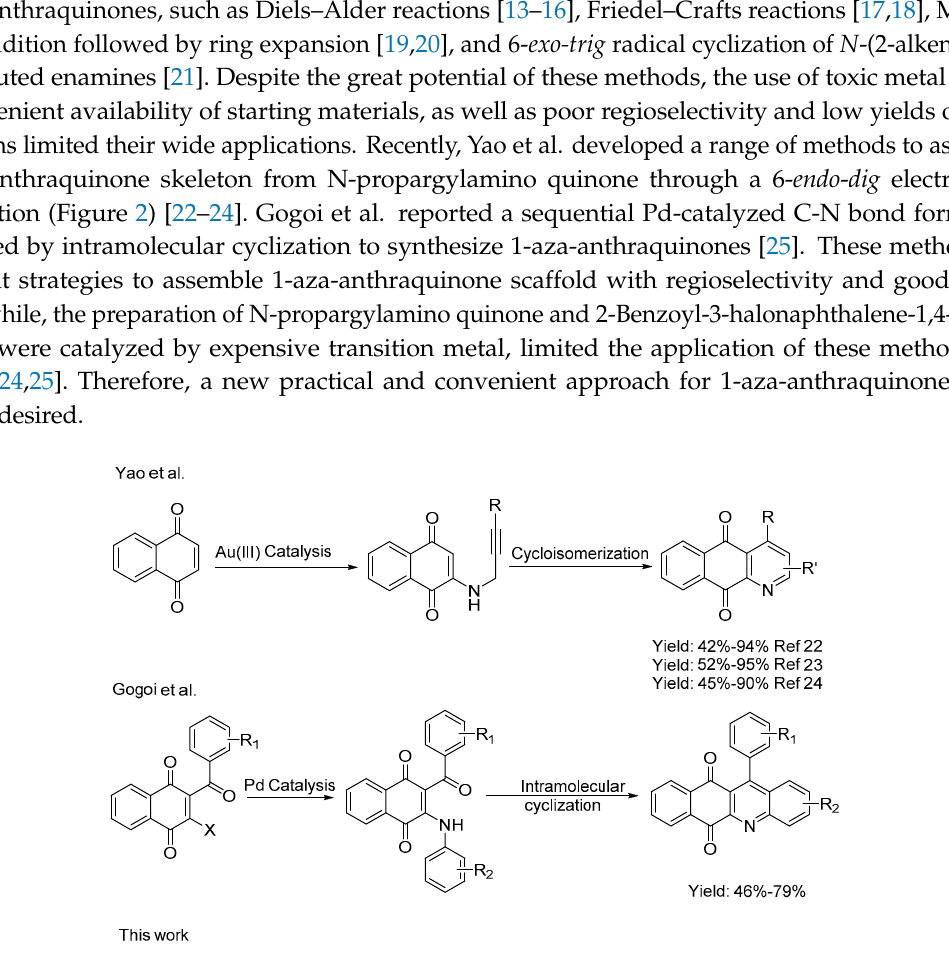
Figure 1. Biologically active aza-anthraquinone derivatives and YCH337.